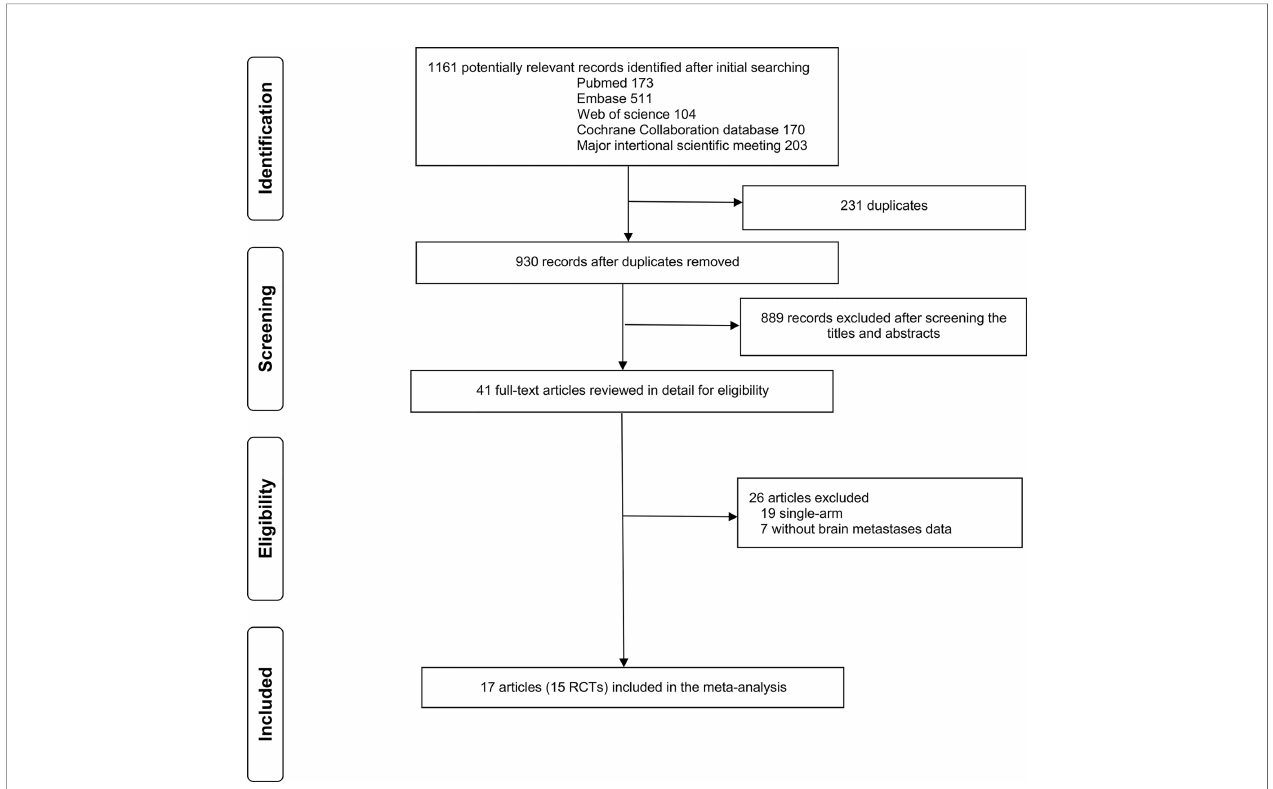
FIGURE 1 | Literature search and selection. RCTs, randomized control